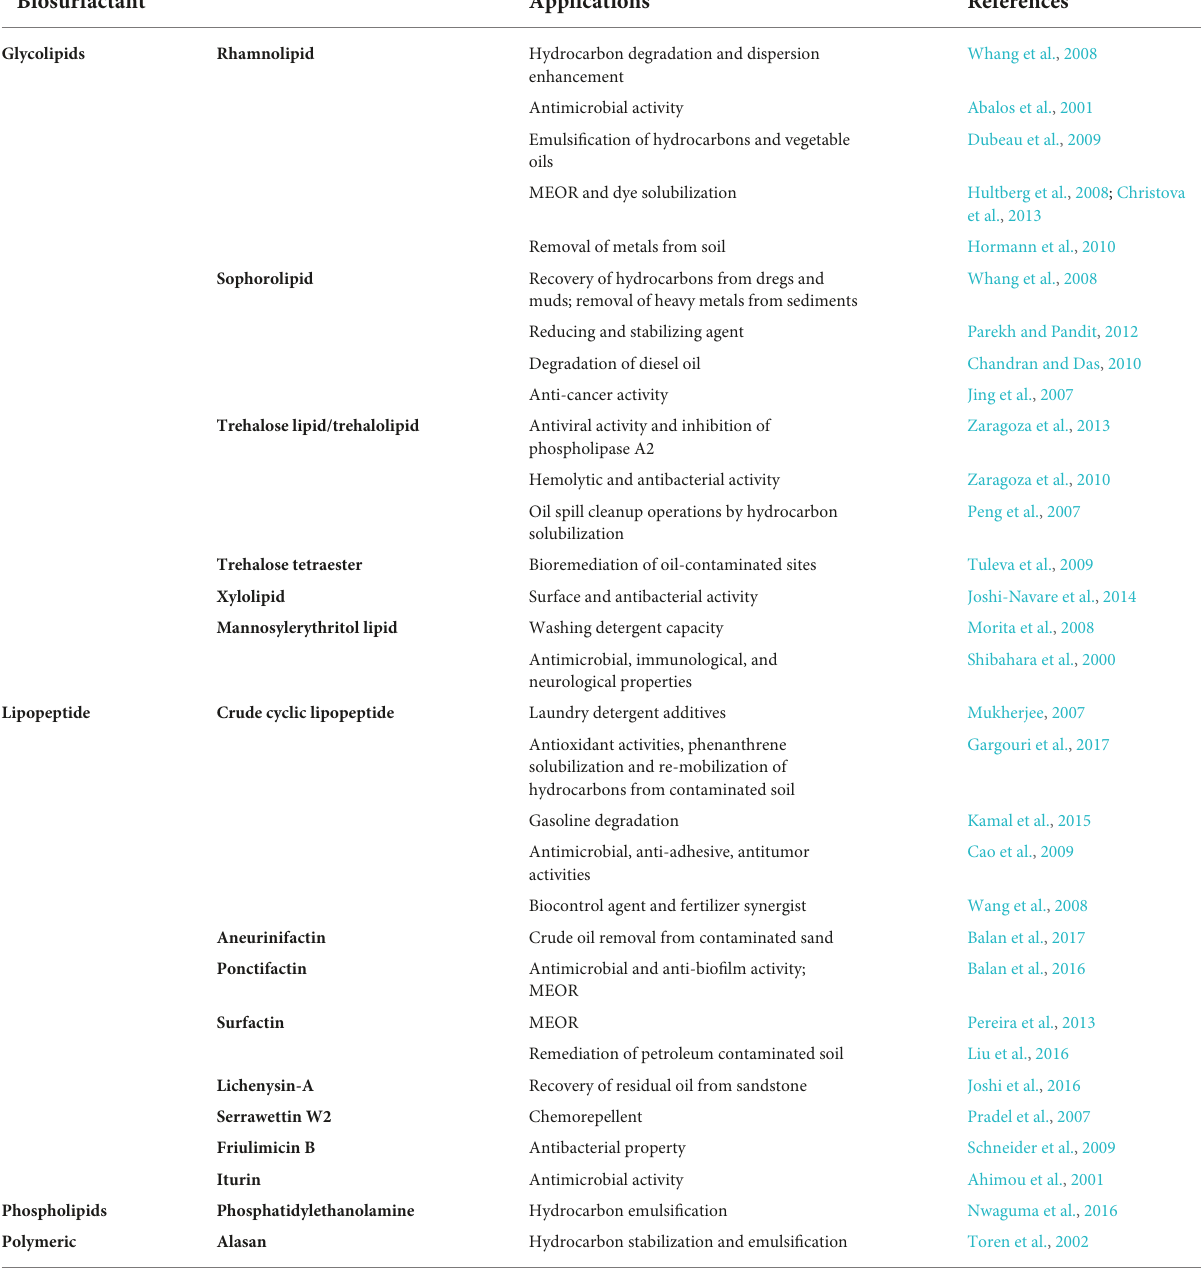
TABLE 6 Potential biosurfactants and their